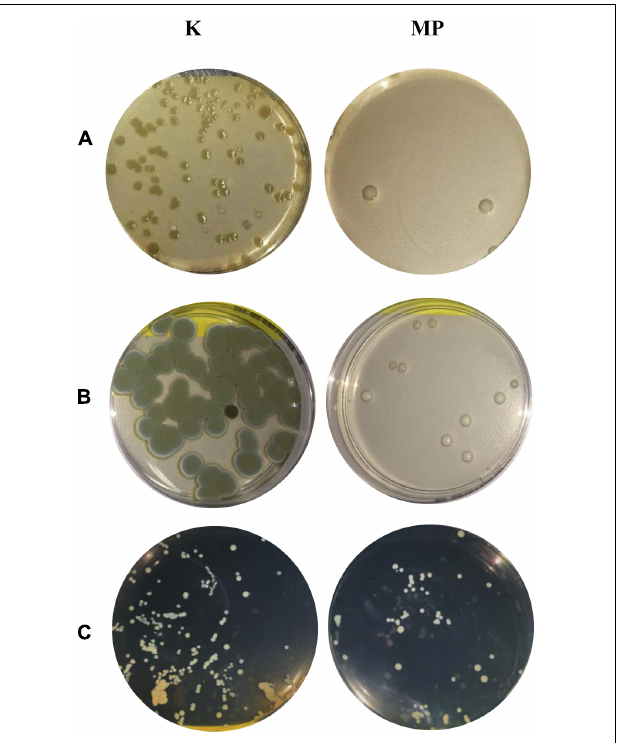
FIGURE 4 | Representative (A) APC and (B) yeast plates of meat, and (C) APC plates of ricotta cheese incubated in the presence of not-functionalized PETs (K) or MTP1-PETs (MP) during 4